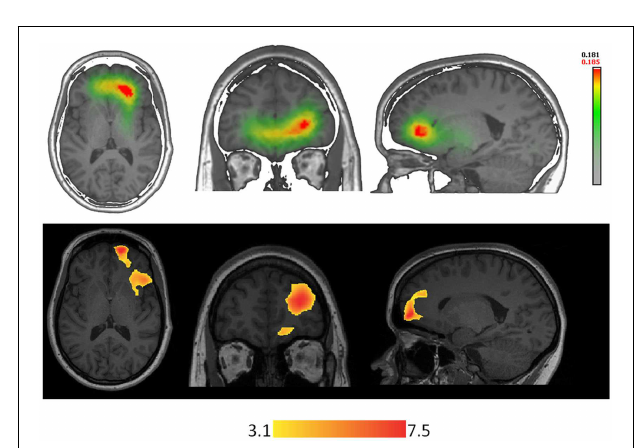
FIGURE 1 | Interictal network revealed by EEG-fMRI . Patients with non-lesional right frontal epilepsy. Marked events inside the EEG-fMRI session: right frontal spikes with phase reversal at F4 (on the left: longitudinal bipolar montage from 204 channels EEG). On the middle: scalp voltage map of the spike (204 electrodes, viewed from the top)